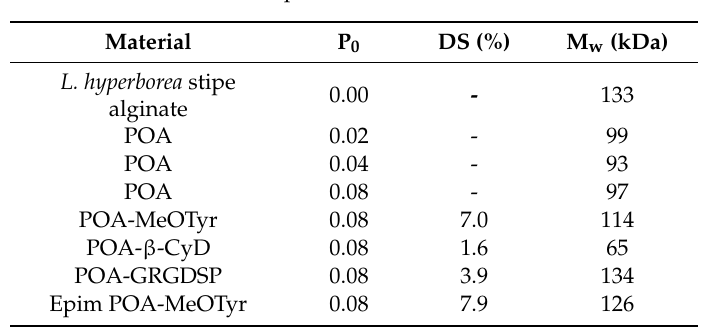
Table 1. Characterization of the functionalized alginates in this study: P 0 = mole periodate per mole uronate residue), degree of substitution (DS, mole substituent per mole uronate residue%), average molecular weight ( M w ). POA: Oxidized alginate. POA-MeOTyr: Oxidized alginate grafted with methyl tyrosine ester. POA- β -CyD: Oxidized alginate grafted with beta cyclodextrin, POA-GRGDSP: Oxidized alginate grafted with the hexapeptide GRGDSP. Epim POA-MeOTyr: oxidized mannuronan